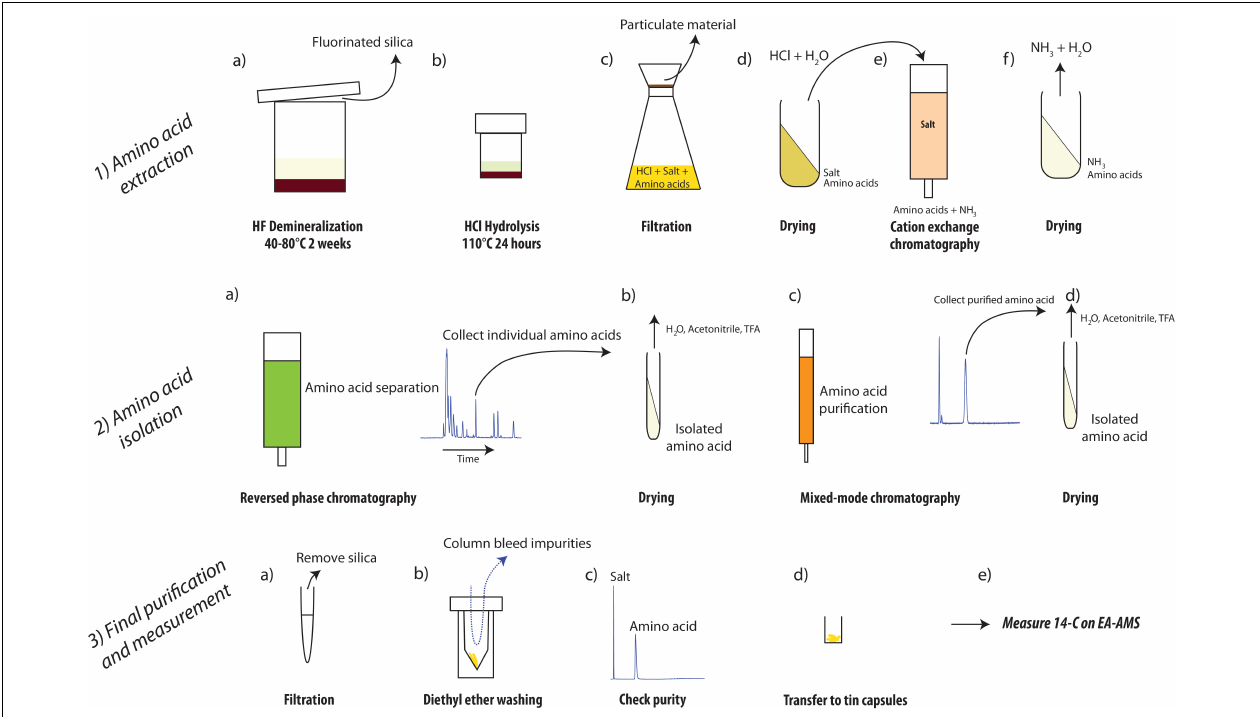
FIGURE 1 | Overview of designed procedure recommended for extraction and preparation of amino acids from sediments for measurement of radiocarbon isotopic composition. Step 3b was not carried out in this study but is detailed in Ishikawa et al. (2018). TABLE 1 | Analyzed amino acids with consensus radiocarbon values from unprocessed reference materials and their respective constant contamination-corrected radiocarbon concentrations measured on processed standards (IIb) based on 23 injections of 80 µ l of standard mixture. Amino acid Standard mixture Radiocarbon measurement µ gC ETH nr. Concentration ( µ g Fm Uncertainty ETH nr. Percent Fm Propagated compound/ml) ( ± abs.) recovery measured uncertainty ( ±